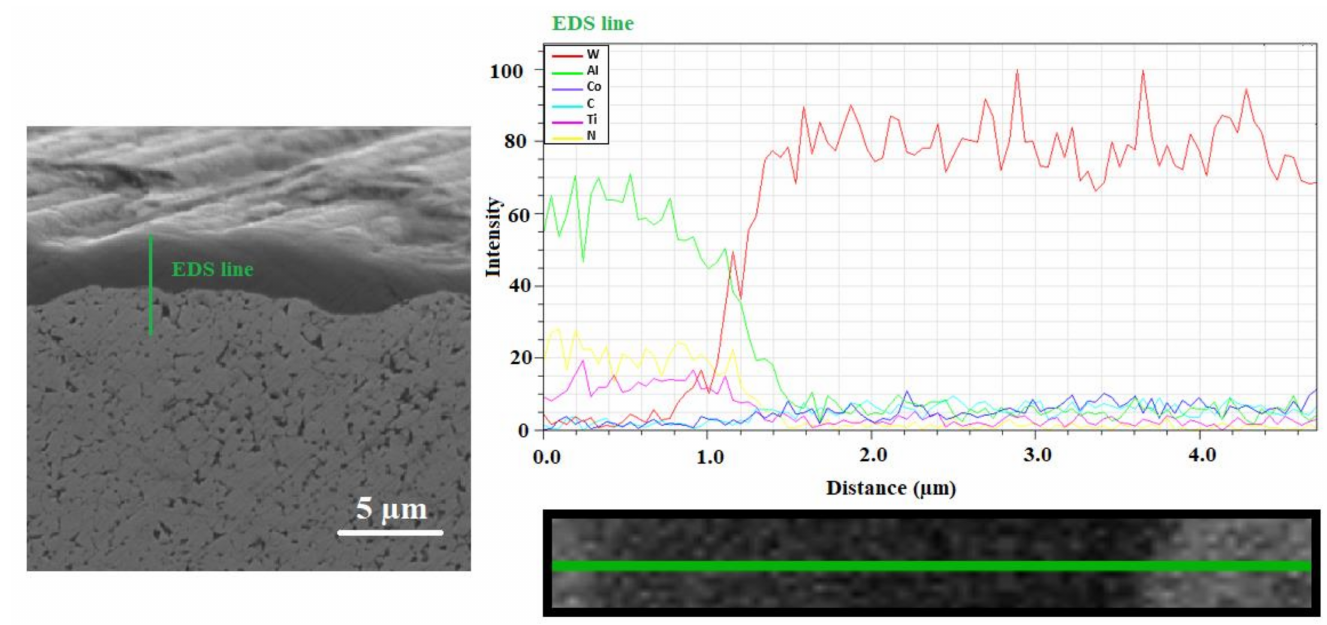
Figure 9. The morphology of the resulting micro-coat in a cross section (SEM) including the EDS measurement in a straight